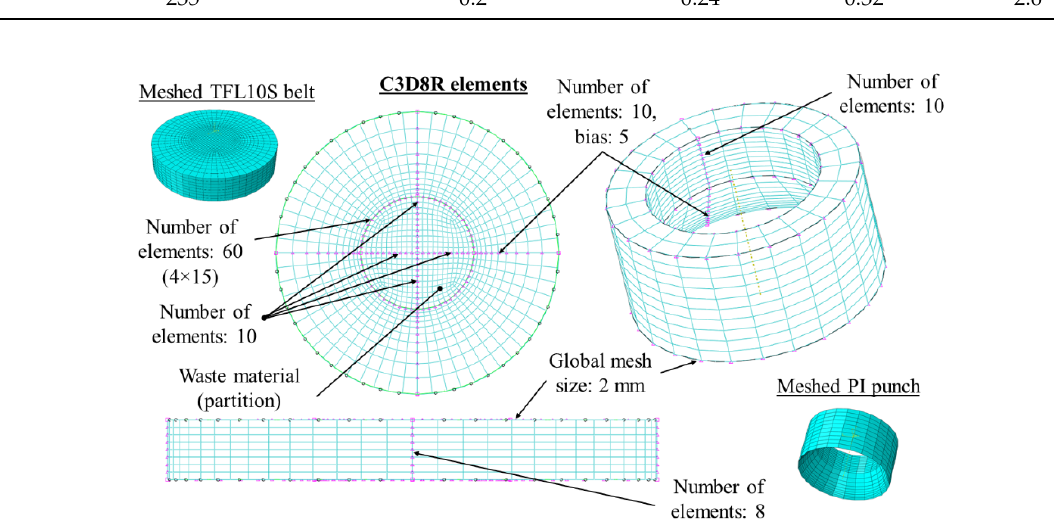
Figure 10. Parameters of the mesh used in FEM analysis. Table 1. Material properties used in FEM modelling of the TFL10 belt.